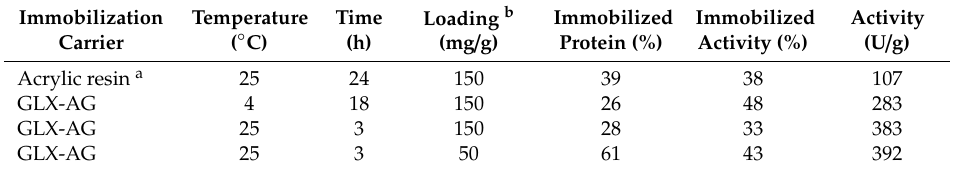
Table 1. Immobilization screening.